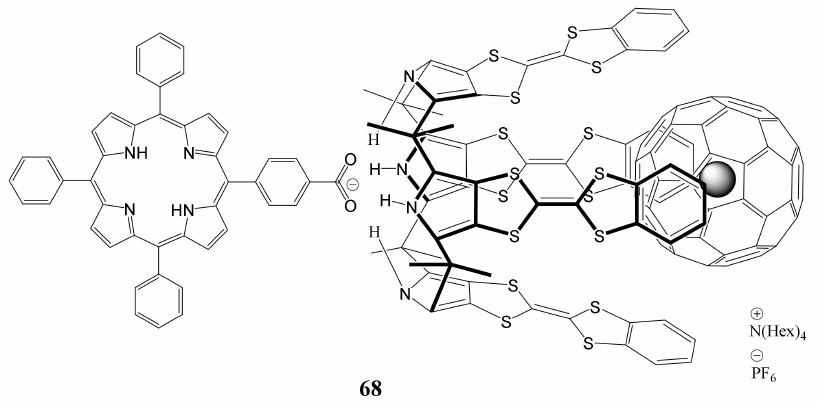
Figure 11. Supramolecular triad 68 composed of porphyrin carboxylate, radical cation 67 , and Li + -C60 radical